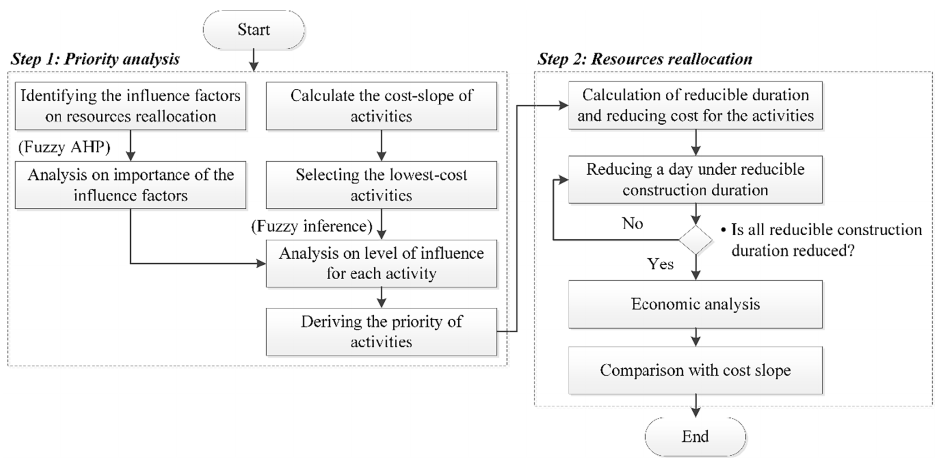
Figure 1. Research